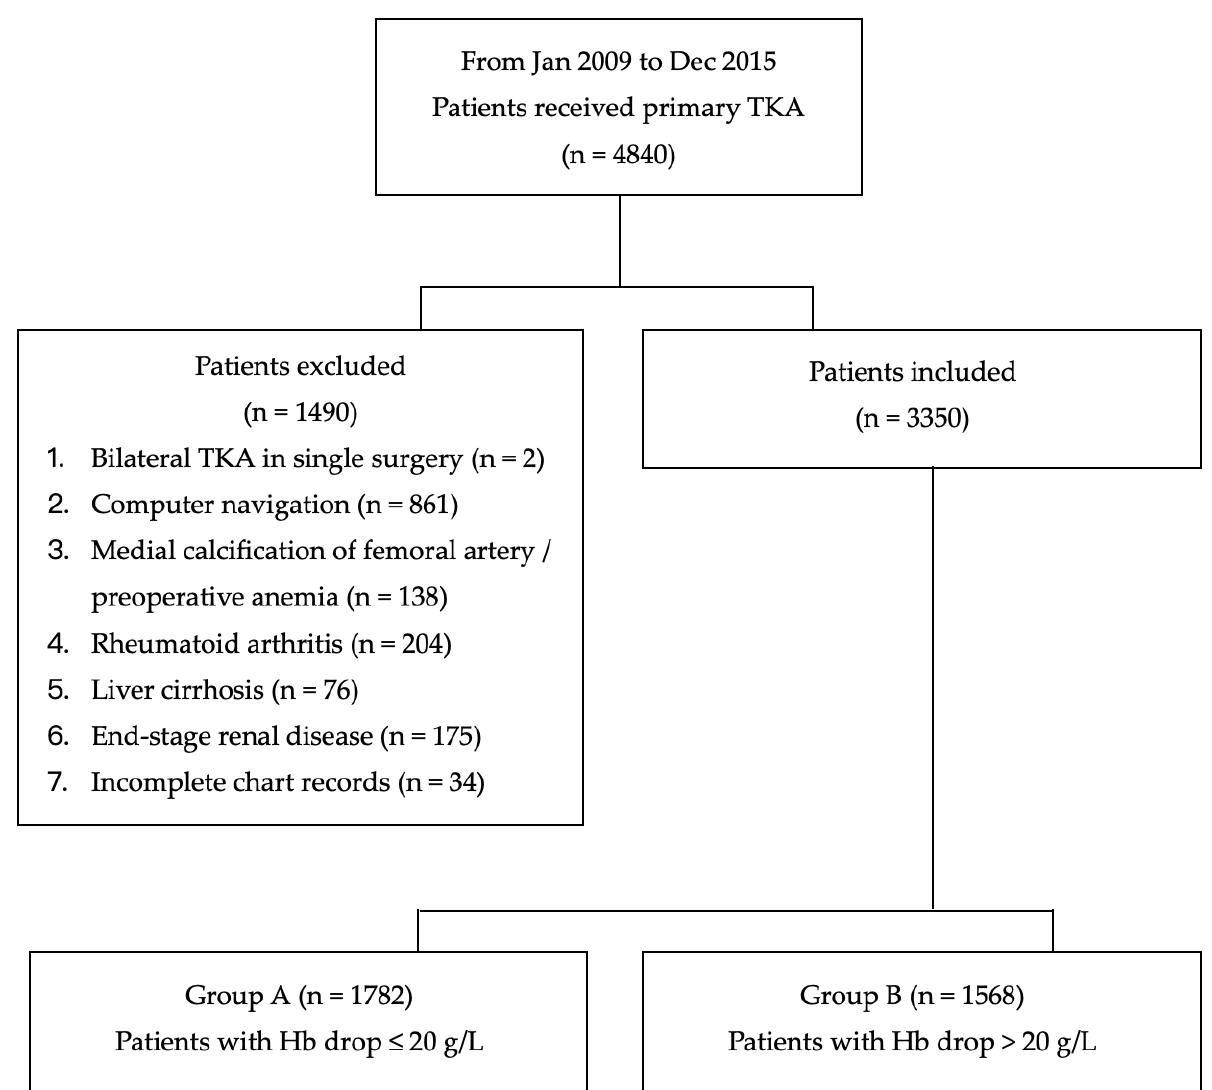
Figure 1. Flow chart of the study. TKA, total knee arthroplasty; Hb, hemoglobin.